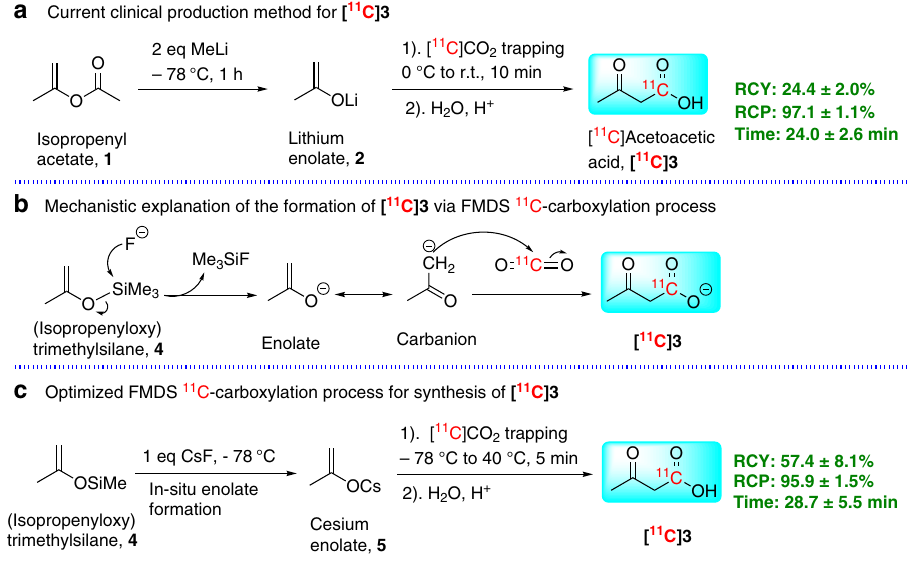
Fig. 1 Methods for synthesizing [ 11 C]3. Two cGMP-compliant synthesis methods for preparing [ 11 C ] 3. a organolithium method; c FMDS 11 C-carboxylation method, and mechanistic explanation of formation of [ 11 C ] 3 via FMDS 11 C-carboxylation approach ( b